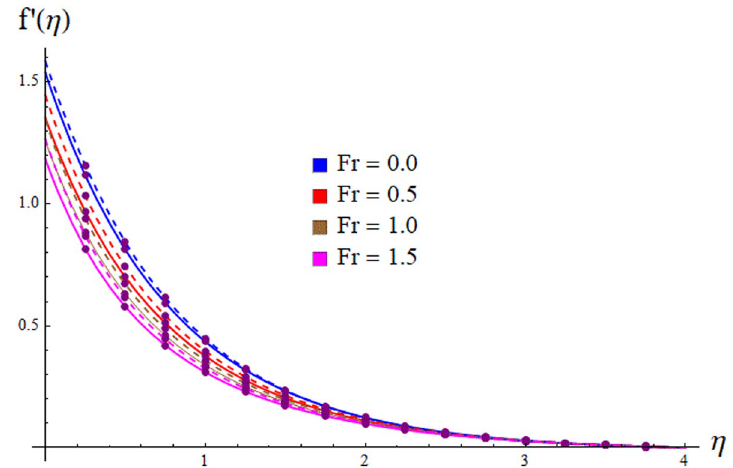
Figure 4. Behavior of velocity f ′ (η) against Fr = 0.0, 0.5,1.0,1.5.